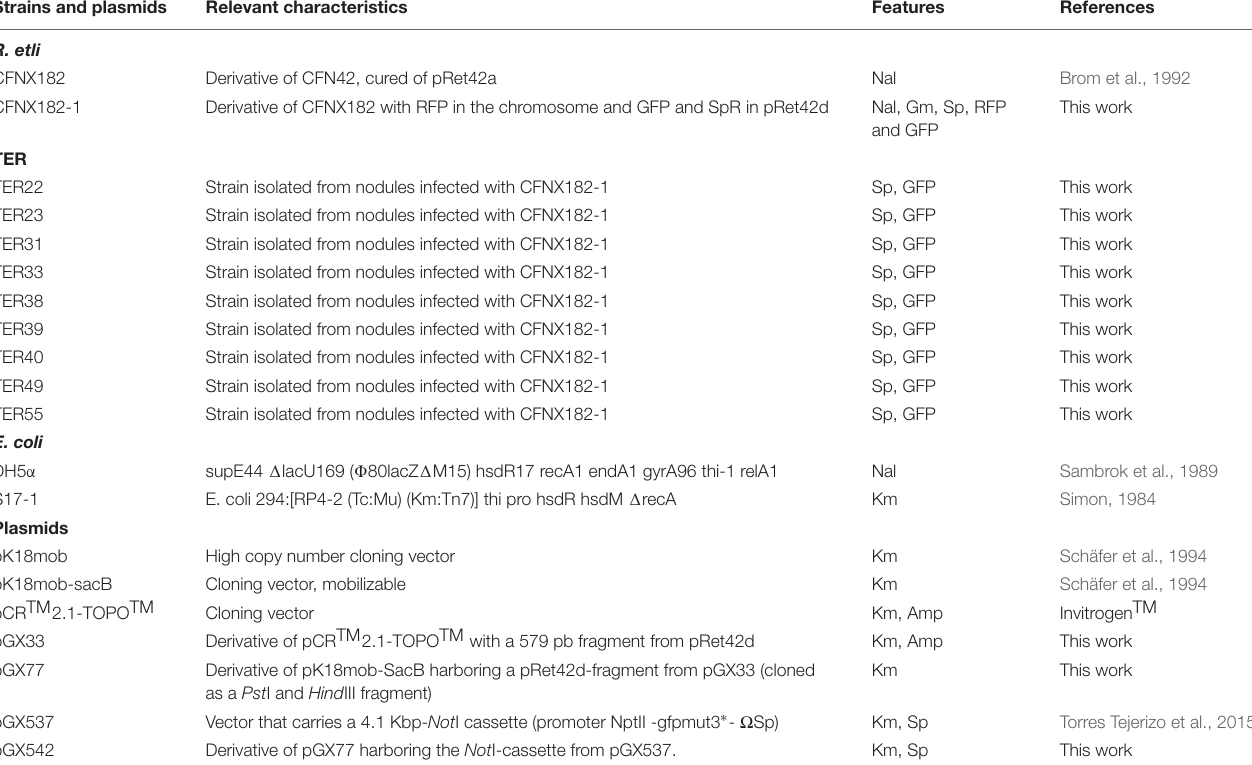
TABLE 1 | Strains and plasmids used in this